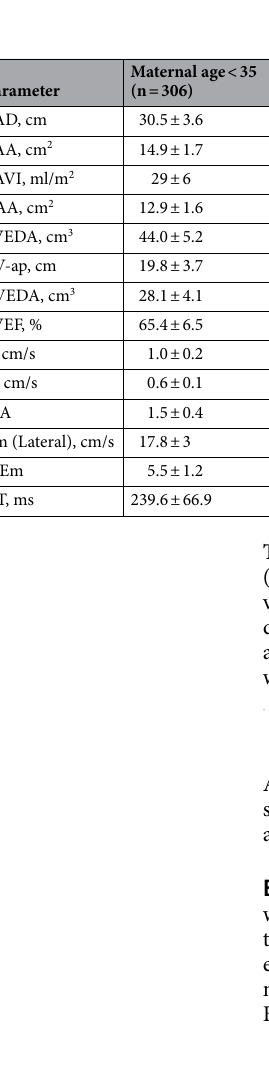
Table 1. Baseline patient characteristics. Gestational age represented the time Echocardiography was measured. Follow-up SBP and DBP were defined as the highest blood pressure collected during the follow-up. Values are given as mean ± standard deviation, median (interquartile range) or count (percentage). BMI body mass index, BSA body surface area, SBP systolic blood pressure, DBP diastolic blood pressure.